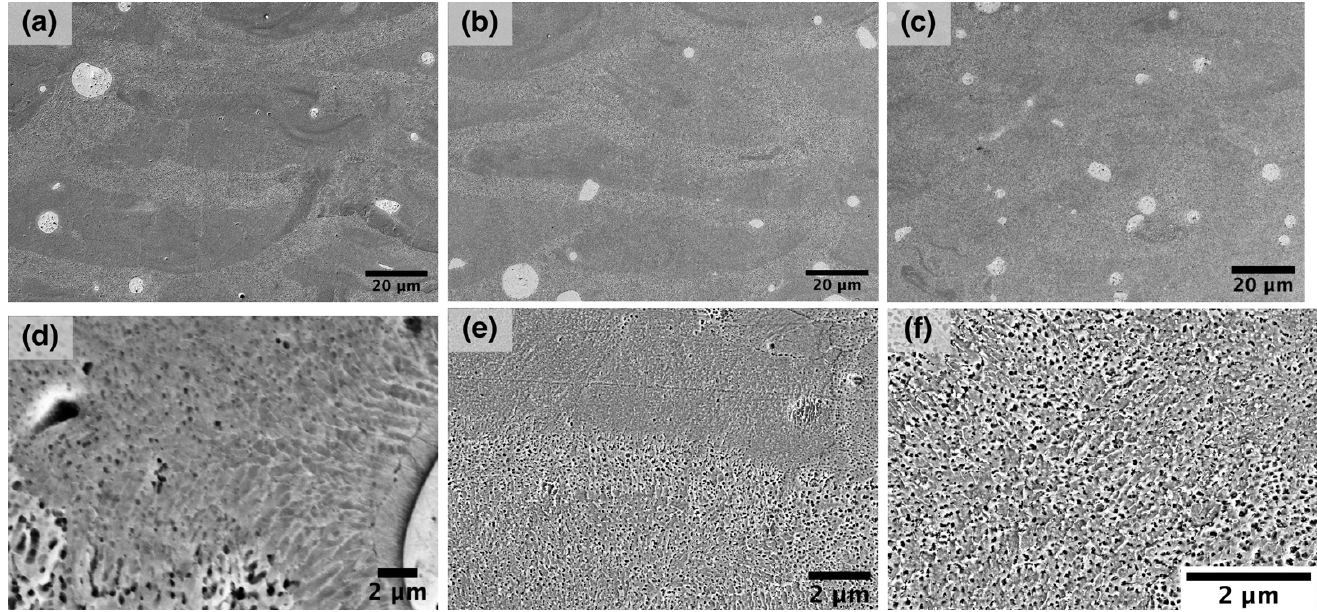
Figure 7. SEM-images of the NiTiNb samples after different heat treatments: ( a , d ) 500 °C for 2 h, ( b , e ) 900 °C for 30 min, and ( c , f ) 900 °C for 2 h.